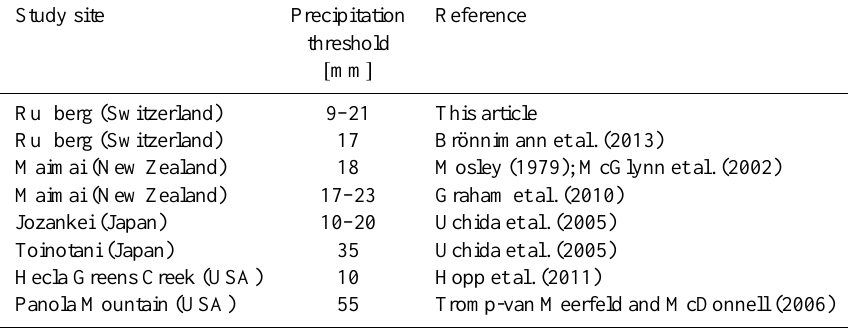
Table 3. Precipitation threshold for runoff generation at different experimental hillslopes.